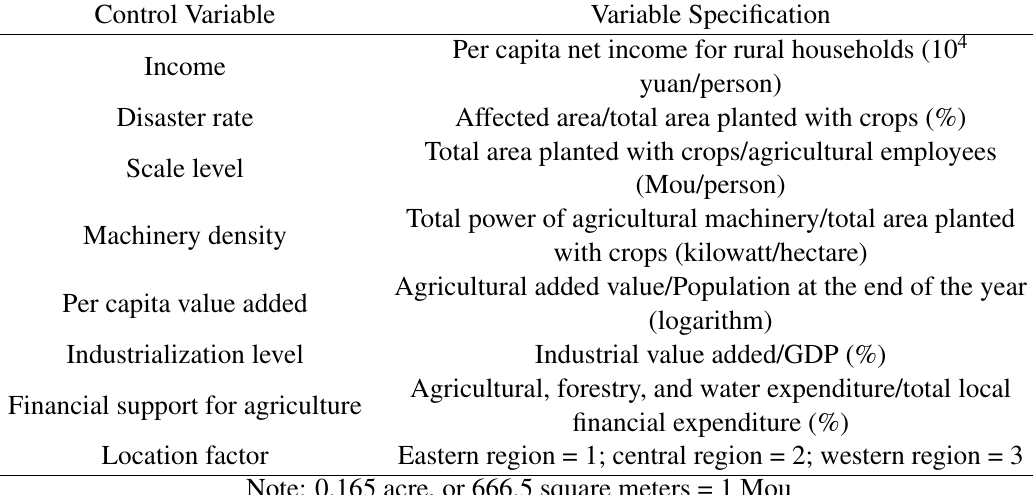
Table 4 Control variables and description.